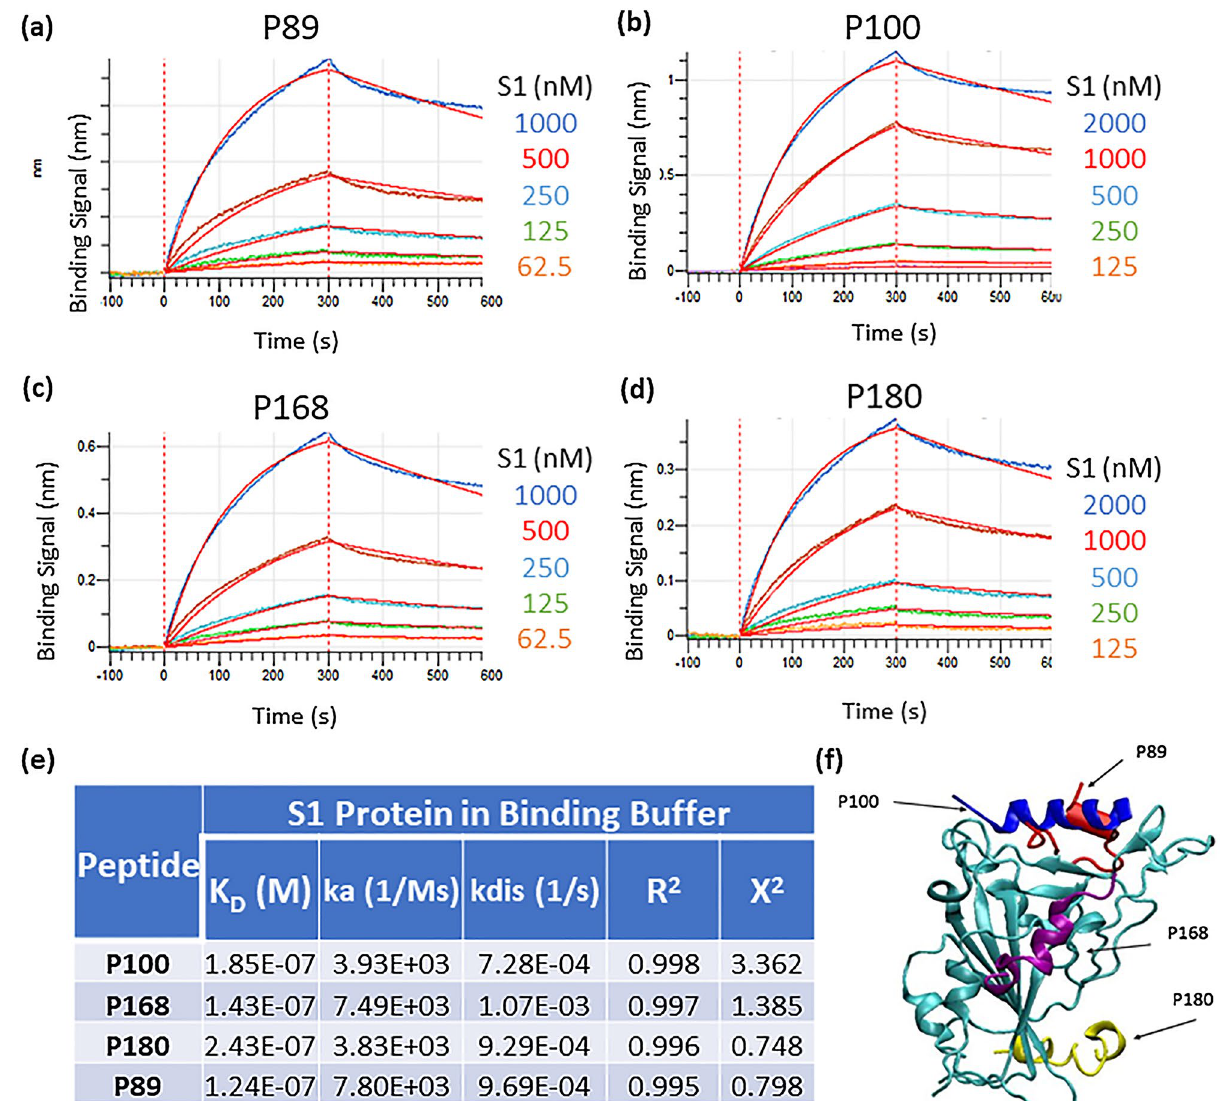
Figure 3. Binding characterization of peptide binders. ( a – d ) BLI binding traces of S1 protein association and dissociation to each of the top four biotinylated peptides (immobilized onto streptavidin sensors). ( e ) The calculated binding constants for the top four peptides. ( f ) Potential binding sites for the top-4 peptides on the RBD subunit of the spike protein (colored in cyan) as identified from the docking simulations. Peptides P89 (red) and P100 (blue) bind to the ACE2 binding site, peptide P180 (yellow) binds to the same site as CR3022 and S2A4 antibodies, while the binding site for peptide P168 (purple) is located similarly to the antibody S309 binding site 25,30–32